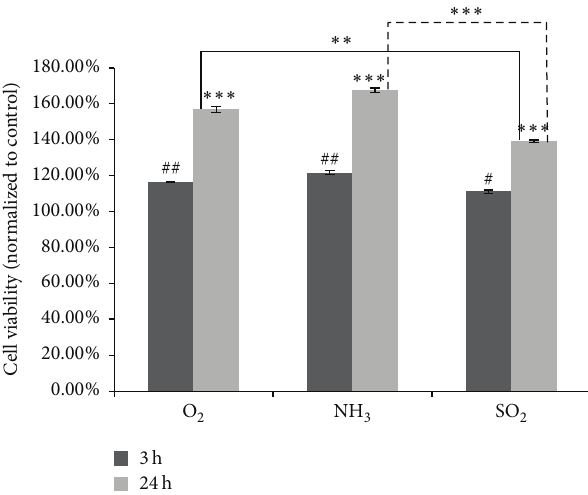
Figure 4: Effect of chemical surface composition on HUVEC pro- liferation. Proliferation of HUVEC on plasma untreated and treated PCLpolymersdeterminedbyMTTassay.Student’s 𝑡 -testwasusedto check the statistical significance. # Statistically significant at 𝑝 < 0.05 for 3 hours compared with control. ## Statistically significant at 𝑝 < 0.01 for 3 hours compared with control. ∗∗ Statistically significant at 𝑝 < 0.01 for 24 hours compared between O 2 and SO 2 plasma treated samples. ∗∗∗ Statistically significant at 𝑝 < 0.001 for 24 hours compared with control and/or between NH 3 and SO 2 treated samples. Mean values ( ± SE) for the respective duplicates are